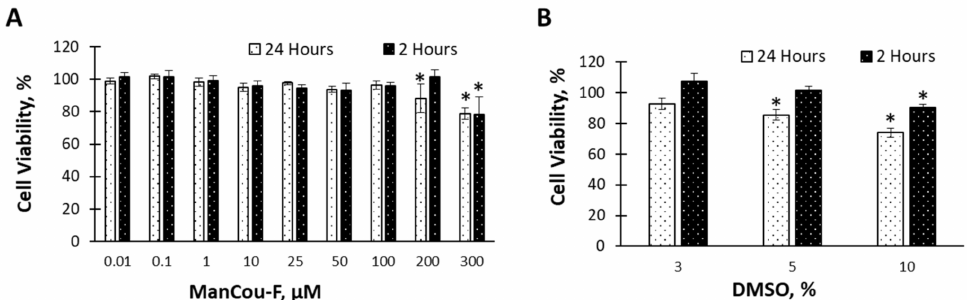
Figure 7. Cell viability of MCF7 cells was assessed using an MTS assay in 96-well plate format and reported as a relative colorimetric change measured at 490 nm. ( A ) ManCou-F cytotoxicity in MCF7 after 2 and 24 h of incubation. Each experiment was carried out in duplicate. ( B ) DMSO cytotoxicity in MCF7 after 2 and 24 h of incubation. A two-tailed t -test was used to detect statistically significant differences: * p < 0.05. Error bars represent the standard